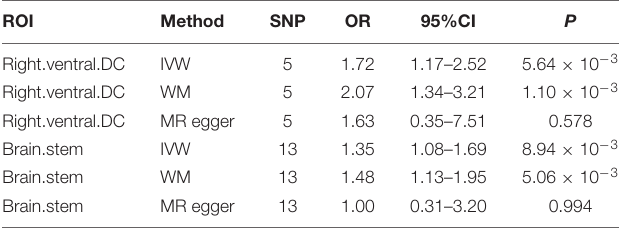
TABLE 3 | MR results between ROI and